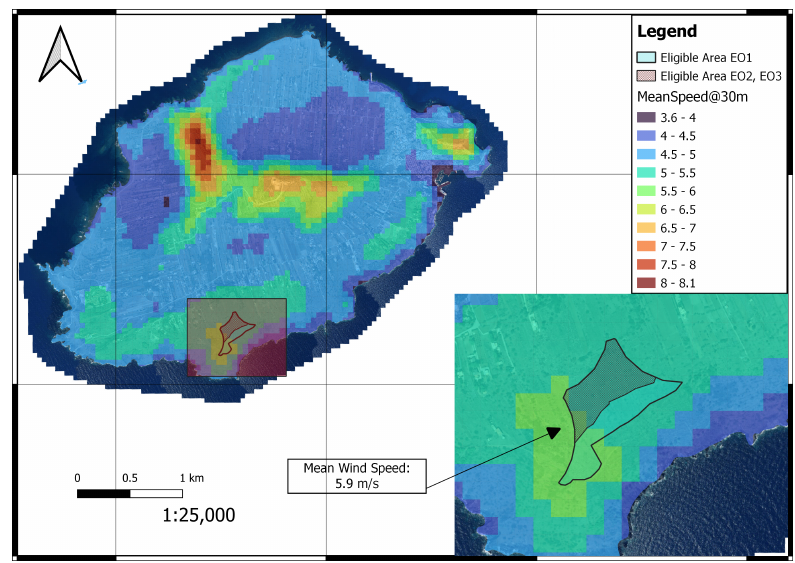
Figure 28. Ustica eligible area and mean wind speed.